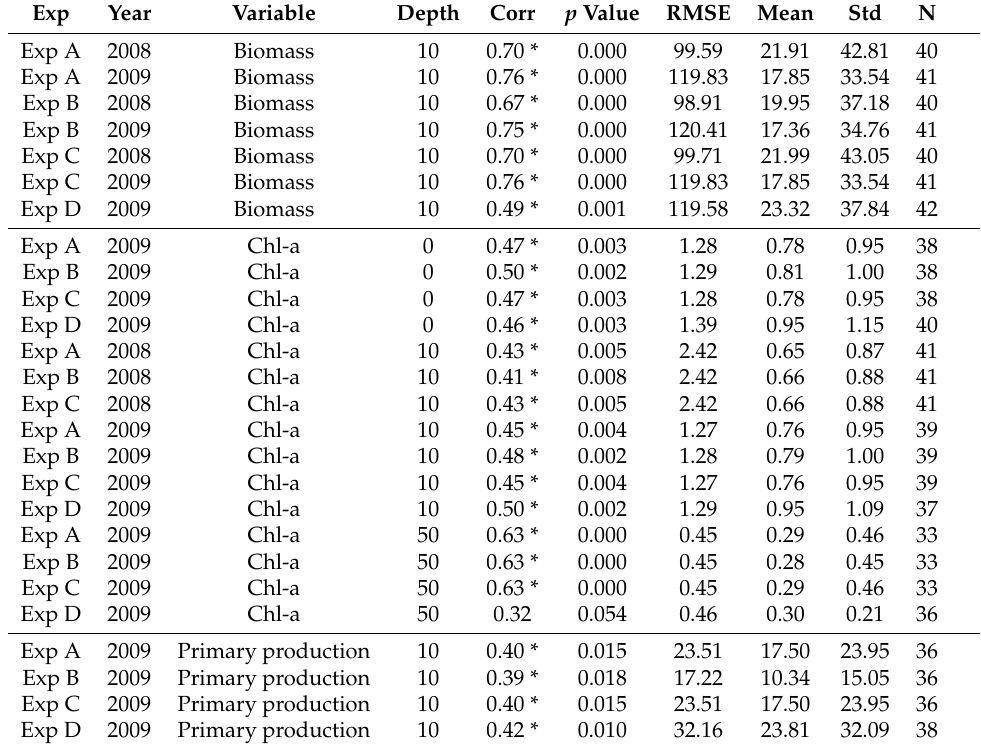
Table of all statistics performed in the experiments Table A1. Pearson correlations for experiments A–D, between observed and modeled variables for 2008–2009 at the shallowest depth available. Significant correlations at the 95% are indicated by